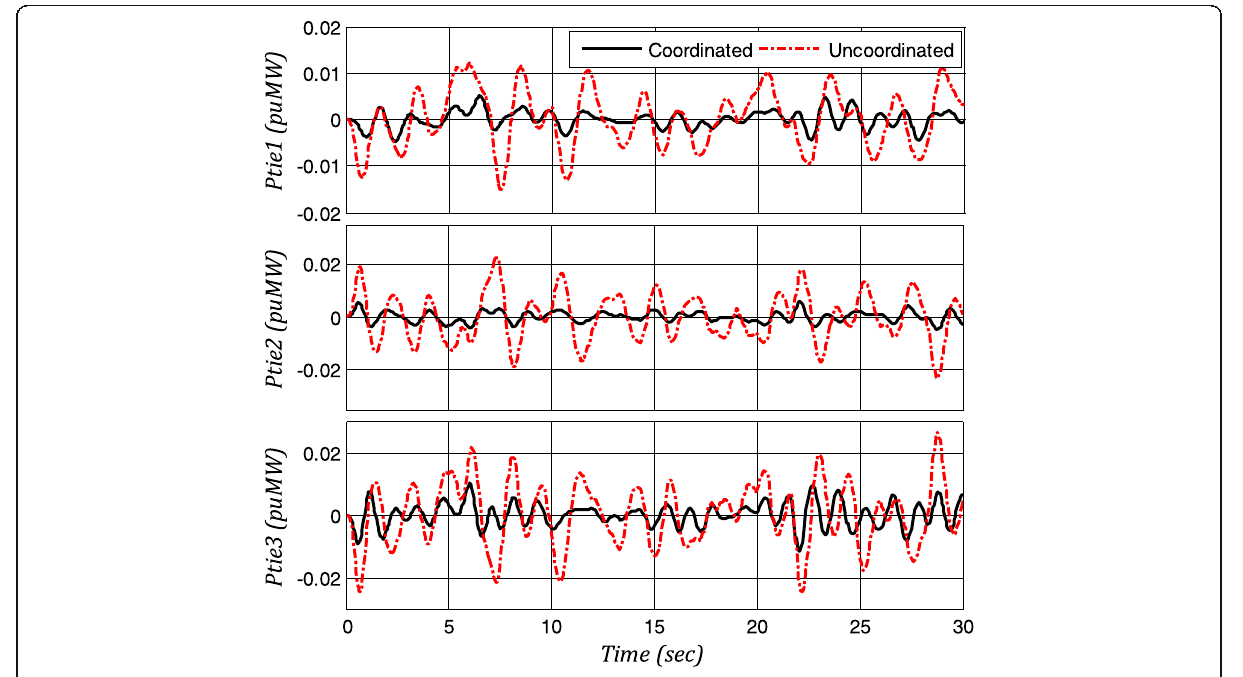
Fig. 10 Tie-line power deviations of the 3-CAs due to